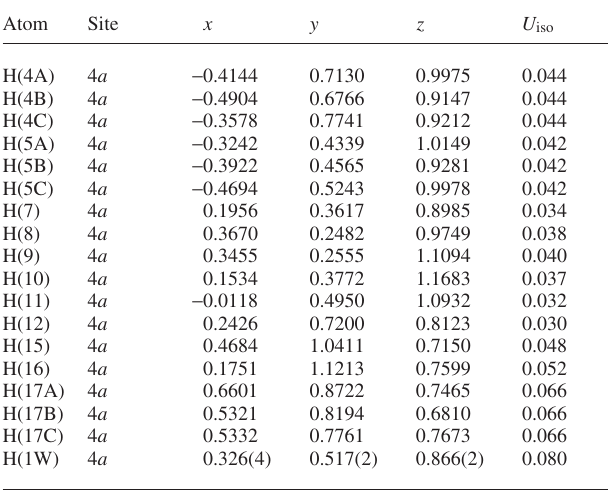
Table 2. Atomic coordinates and displacement parameters (in Å 2 )